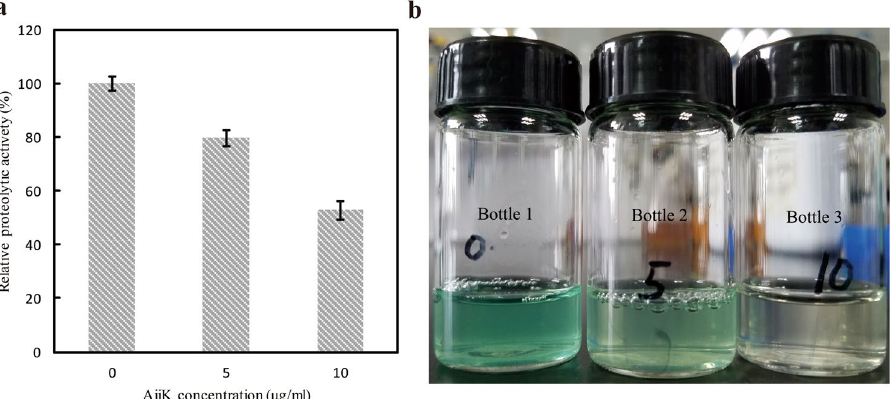
Figure 7. Effect of AiiK on virulence factor production. ( a ) The extracellular proteolytic activity of P. aeruginosa PAO1. ( b ) The pyocyanin production of P. aeruginosa PAO1. Bottle 1: 0 μ g/mL of AiiK; Bottle 2: 5 μ g/mL of AiiK; Bottle 3: 10 μ g/mL of AiiK. All experiments were carried out in triplicates.